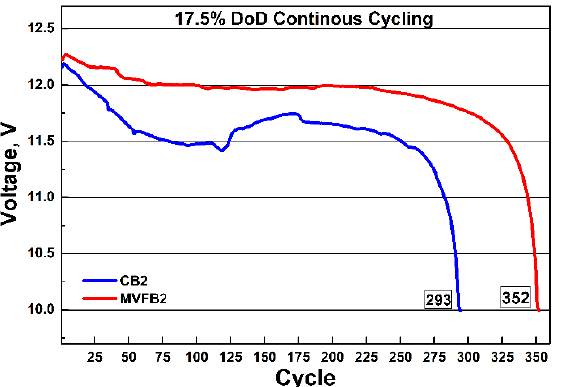
Figure 7. Final discharge voltages of control battery CB2 and battery formed with external influ- ence of multivector field MVFB2 cycled at 17.5% DoD. of multivector field MVFB2 cycled at 17.5%